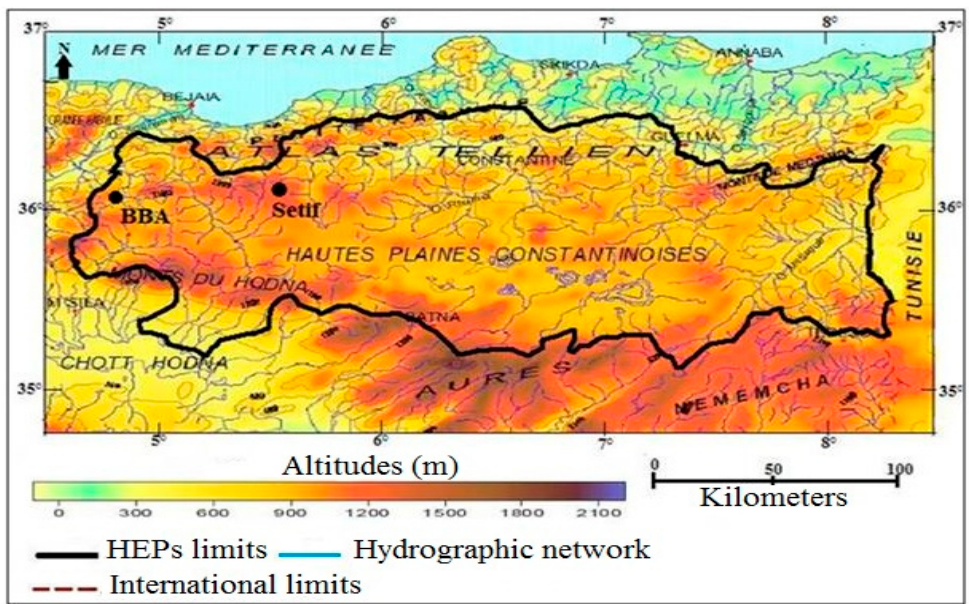
Figure 1. Geographical location of the study area (source [23]).